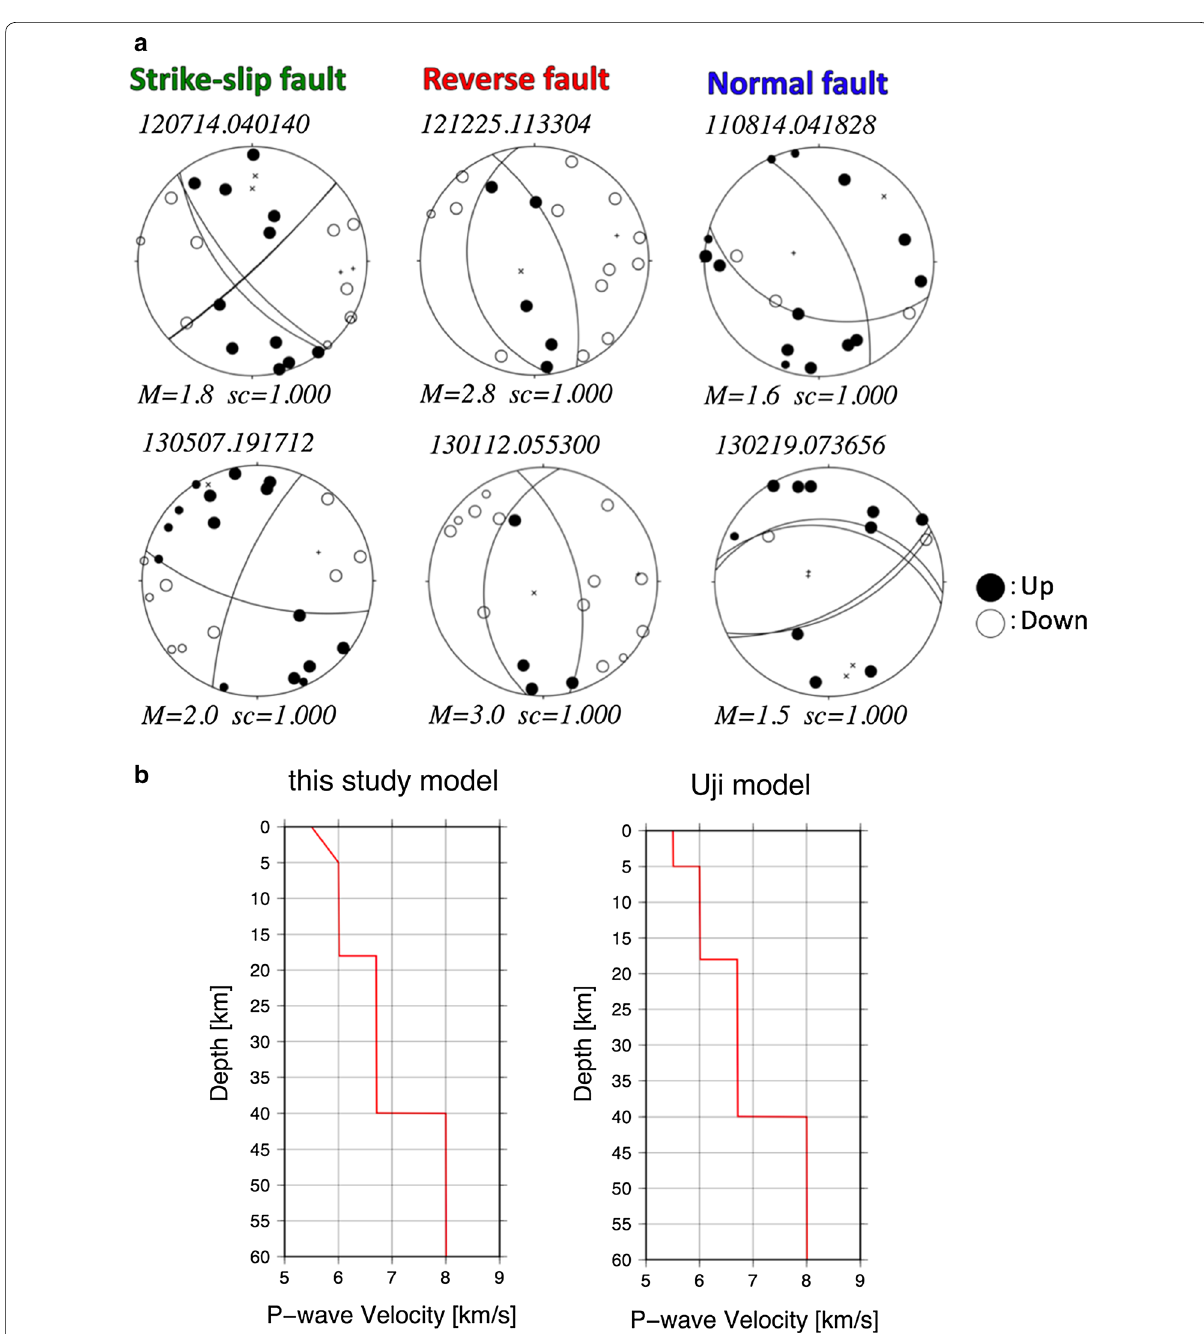
Fig. 4 Examples of focal mechanisms determined and P-wave velocity structure used in this study. a The focal mechanisms are projected onto the upper hemisphere using the stereo projection (Wulff net). Solid and open circles respectively indicate the upward (compressional) and downward (dilatational) first motions. The occurrence time is shown at the top of each focal solution, and the magnitude and score are shown at the bottom where “score” means a ratio of the data consistent to the obtained solution to the total data. b The left panel represents the P-wave velocity struc- ture used in this study and the right panel shows the structure used in the hypocenter determination for the central Kinki district by the Disaster Prevention Research Institute, Kyoto